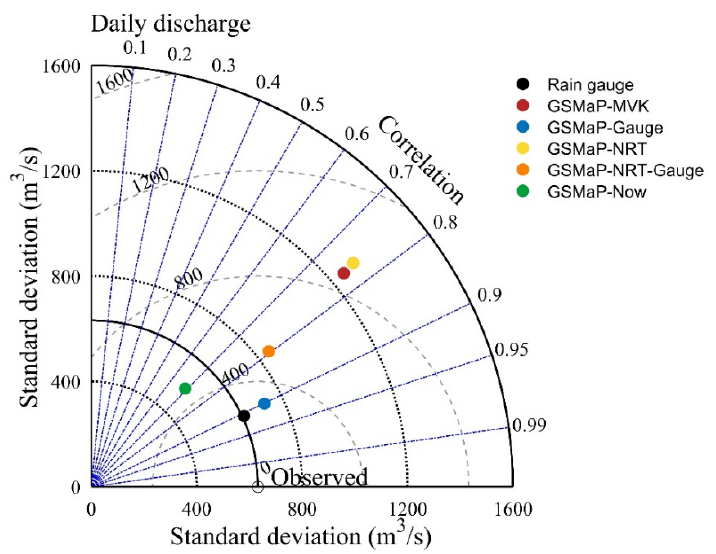
Figure 11. Taylor diagrams showing the overall performance of daily streamflow simulation from 29 March 2017 to 31 December 2018 at the Tangnaihai hydrological station using the rain-gauge-based precipitation data set and the five GSMaP SPPs based on the observed discharge data.